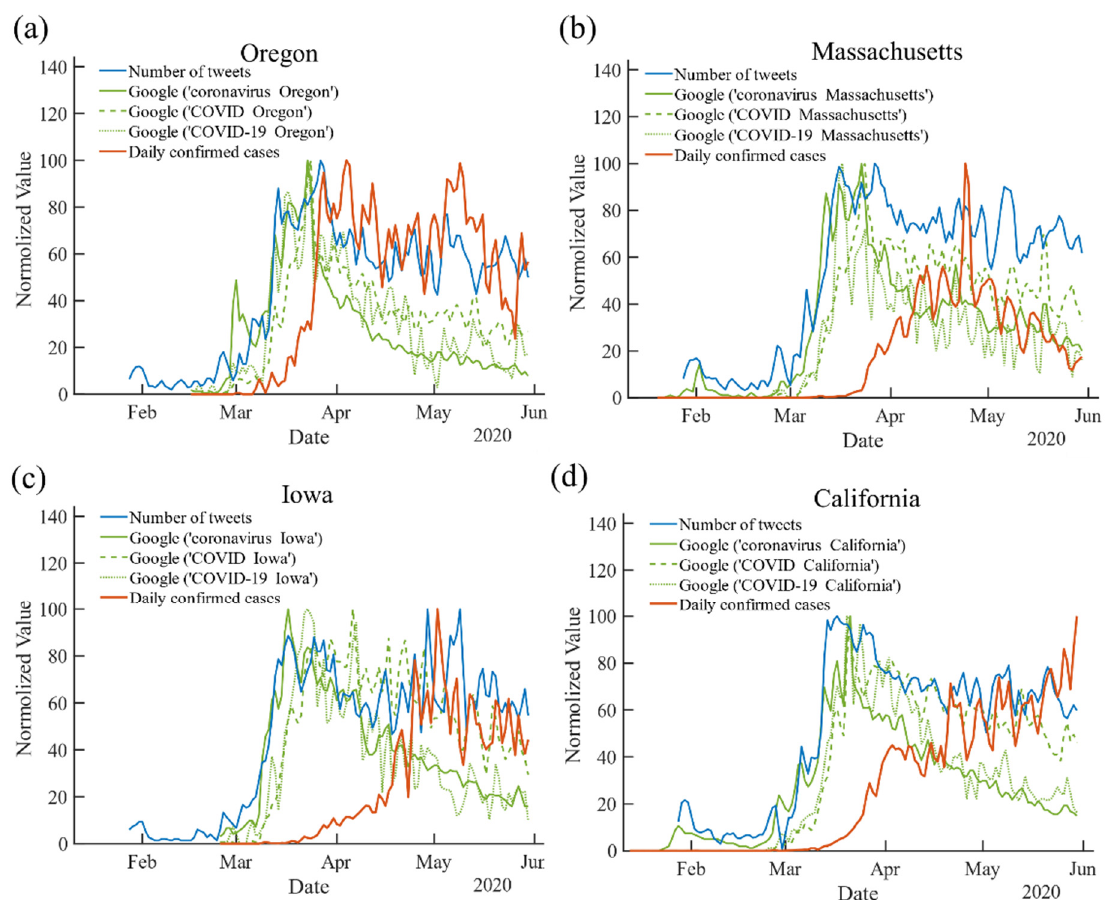
Figure 1. The number of COVID-19 related tweets, Google Trends index using different COVID-19 keywords (integrated with the state’s full name) and daily infection numbers in 4 states till 30 May 2020: ( a ) Oregon, ( b ) Massachusetts, ( c ) Iowa, ( d ) California. The values of each curve are smoothed by a 3-day-average to reduce the noise and are then normalized to [0, 100] for comparison.